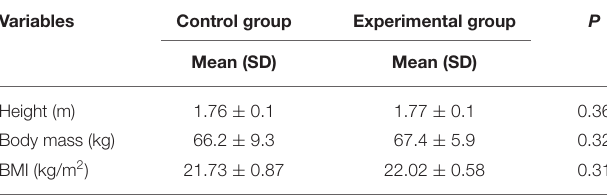
TABLE 1 | Mean and standard deviation of descriptive research